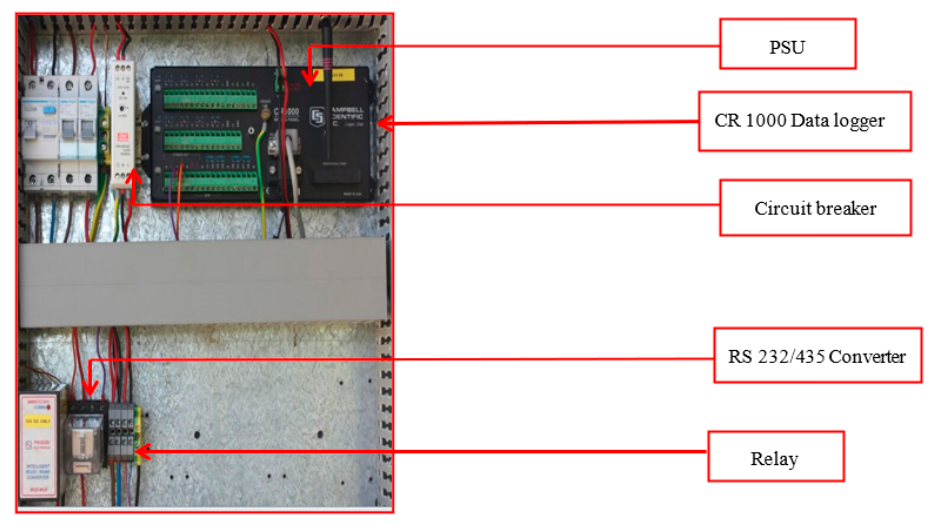
Figure 3. The data acquisition system (DAS); PSU—power supply unit.